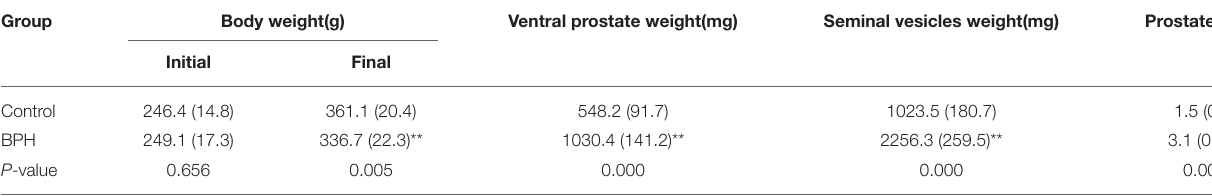
TABLE 2 | Variation of biometric and physiological parameters in control and BPH rats.